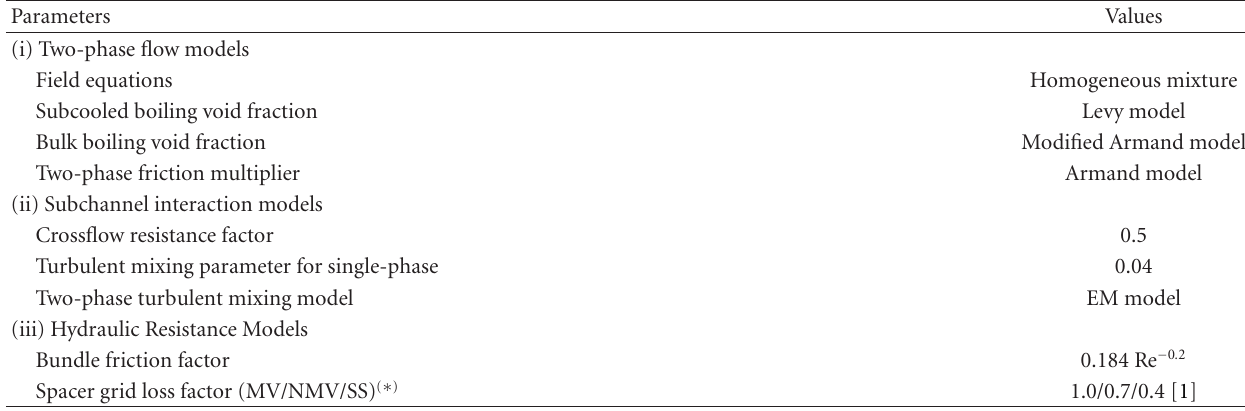
Table 1: MATRA models for an analysis of PSBT benchmark exercises.